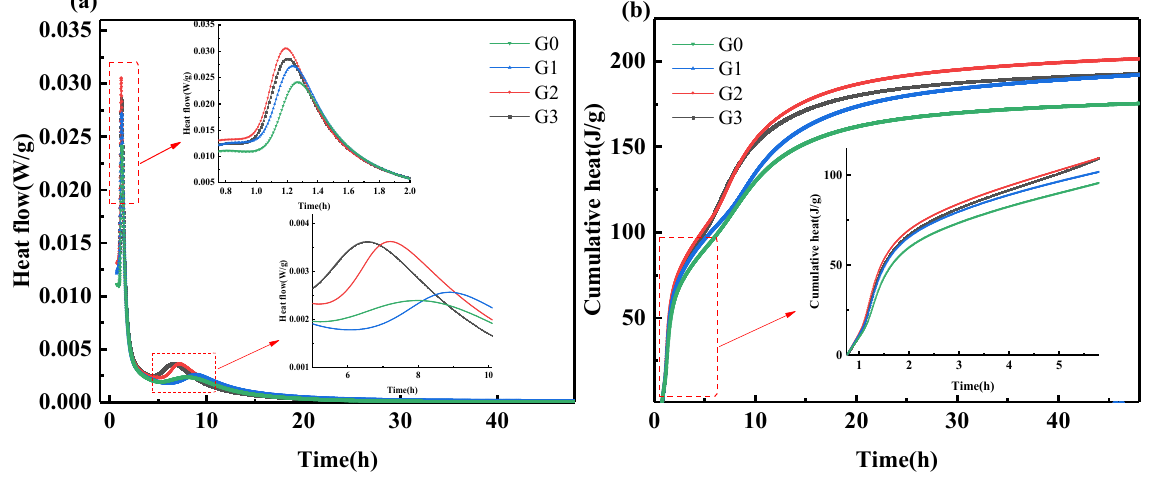
Figure 7. ( a , b ) Isothermal calorimetry results.